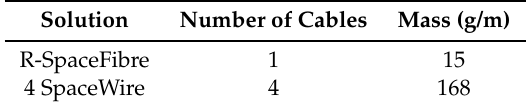
Table 5. R-SpaceFibre interface vs. four SpaceWire interfaces cable